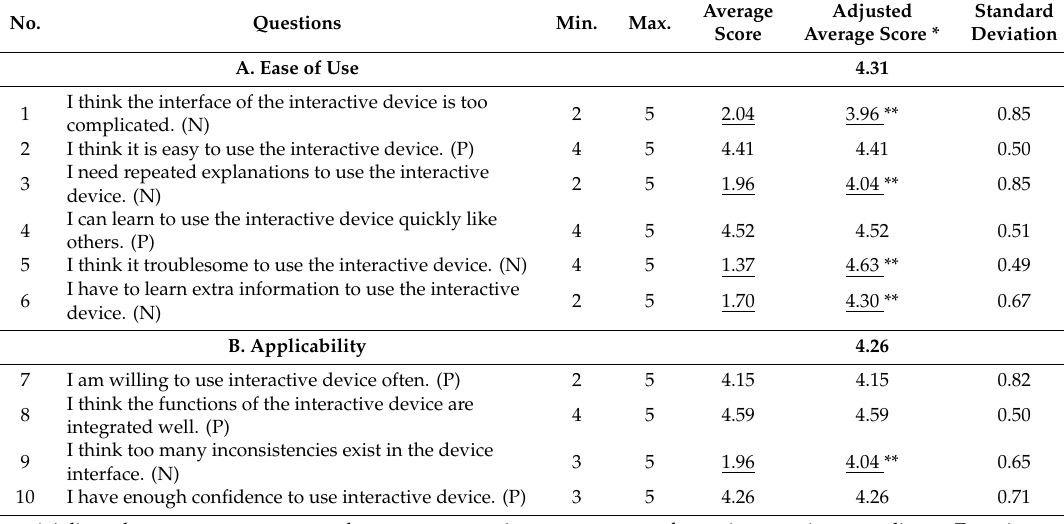
Table A2. Questions about system usability in the questionnaire and statistics of the average scores of the answers to the questions.